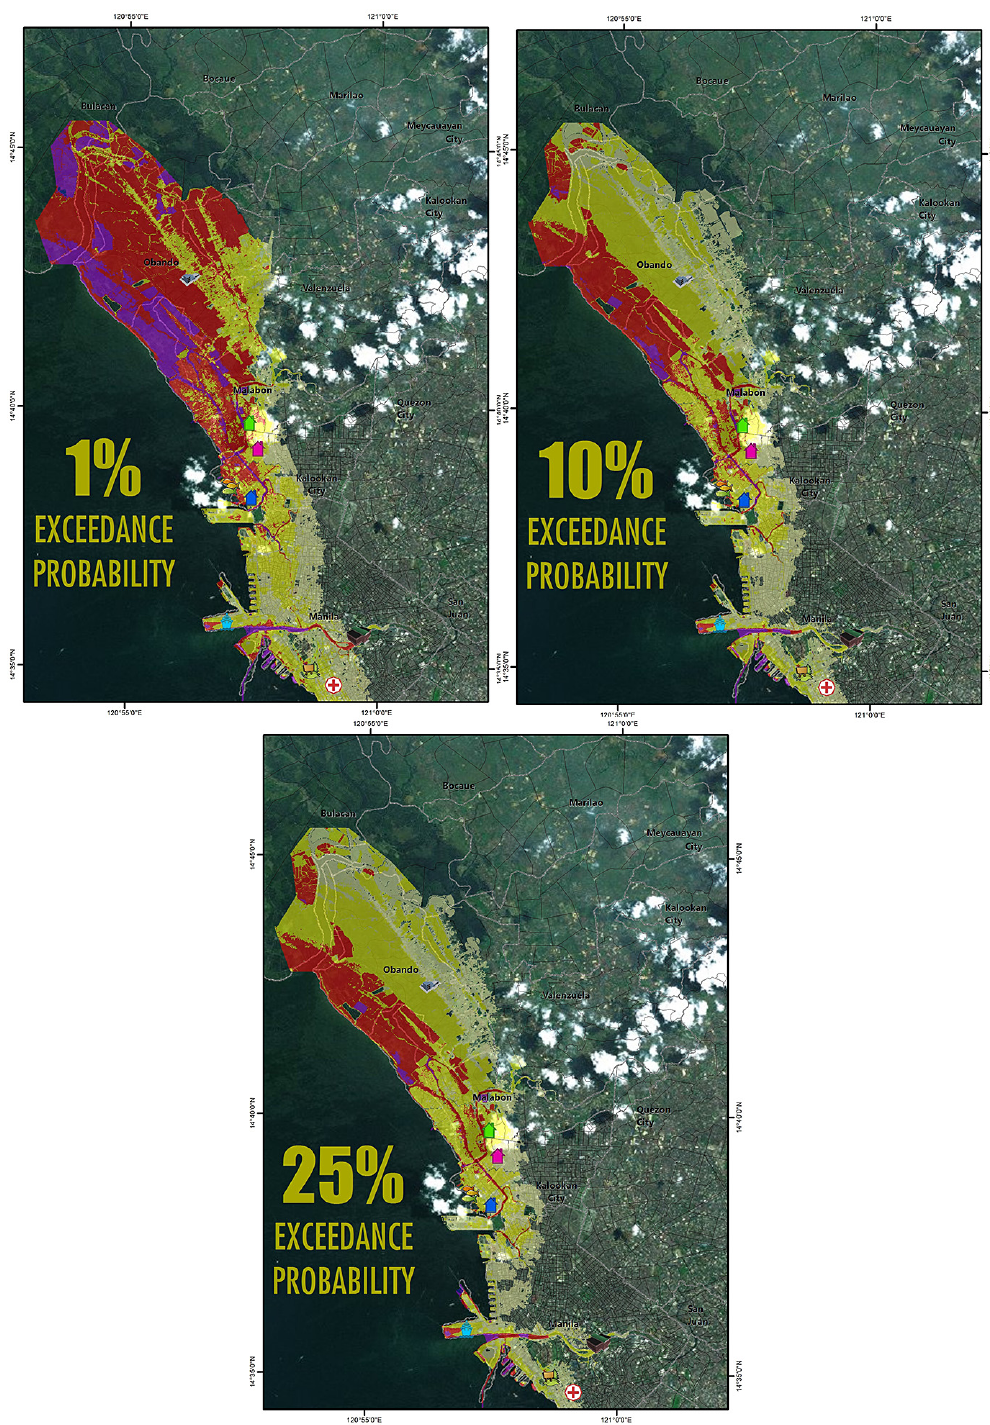
Figure 11. Storm surge inundation maps for PSWS 3 (please refer to Fig. 12 for the